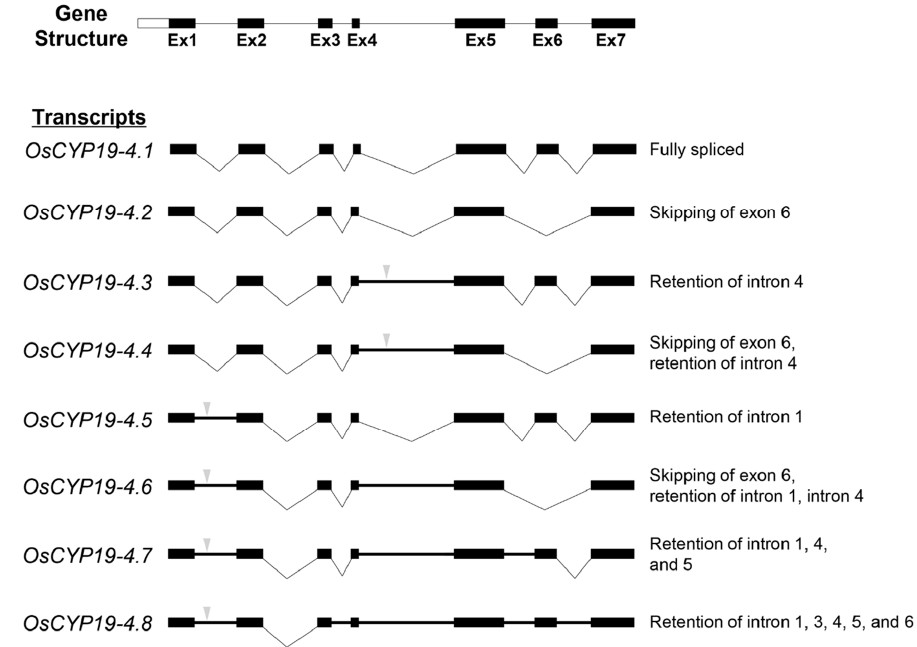
Figure 1. Schematic diagram illustrating the alternative splicing events of OsCYP19-4 during cold stress. Gene structure of OsCYP19-4 . Scheme of the fully spliced mRNA and seven alternative splicing (AS) isoforms of OsCYP19-4 . Black boxes represent the seven exons, whereas the six intronic regions are shown as straight or bent (“V”) lines. Bold lines represent intron retentions. Inverted triangle ( ▼ ) indicates premature termination codons (PTCs). AS types are represented at the right.